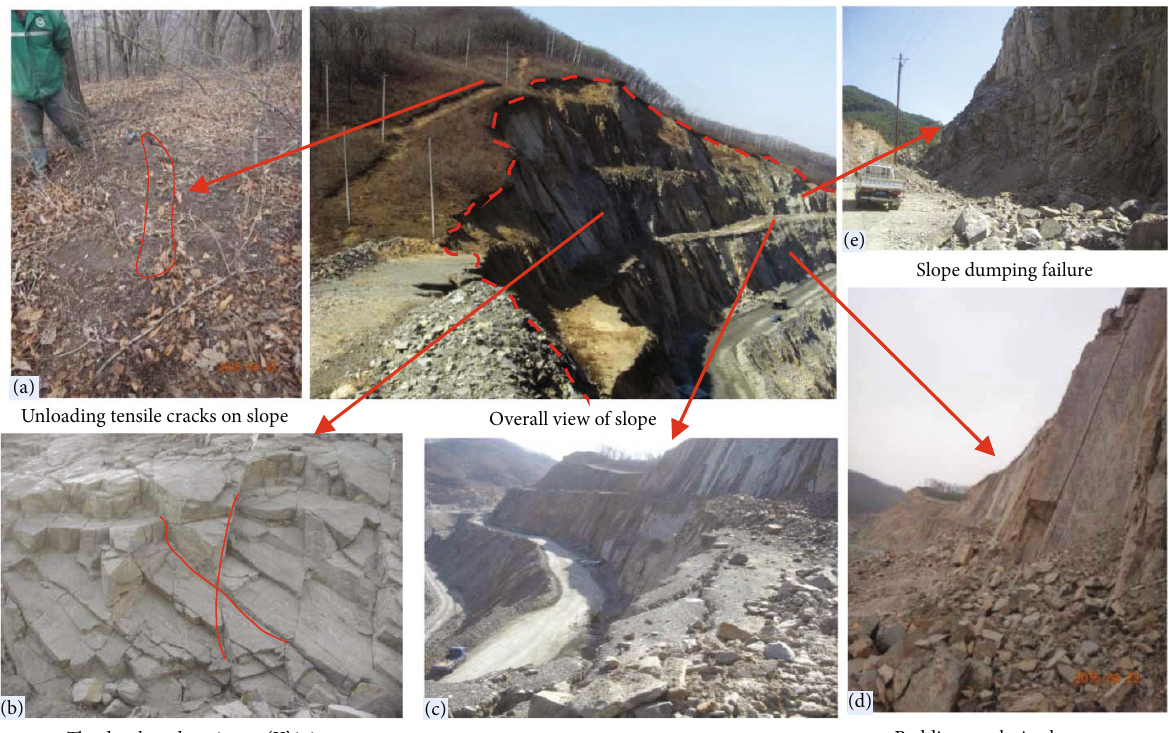
Figure 6: Deformation and failure diagram of the